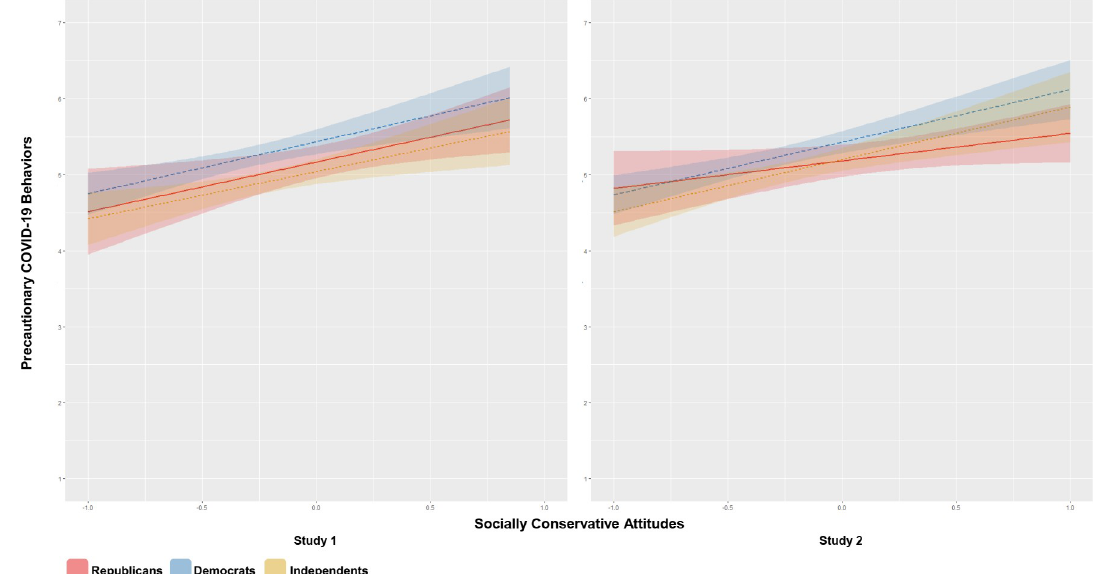
Fig 3. Effects of suppressor variables on socially conservative attitudes – COVID-19 precautions relationship. Studies 1 and 2 conditional effects of moderated linear regressions, in which the previously-identified suppressor variables were added to the models specified in Fig 1. These (centered) suppressors were economic conservatism, trust in scientists as information sources, trust in liberal and moderate figures as information sources, and liberal media consumption. Further, each of these suppressor variables interacted with political party affiliation in the model, because they had different effects on precautionary behavior as a function of party identification (see Fig 2 and S3 Appendix for details). Bands around regression lines are 95% confidence intervals.